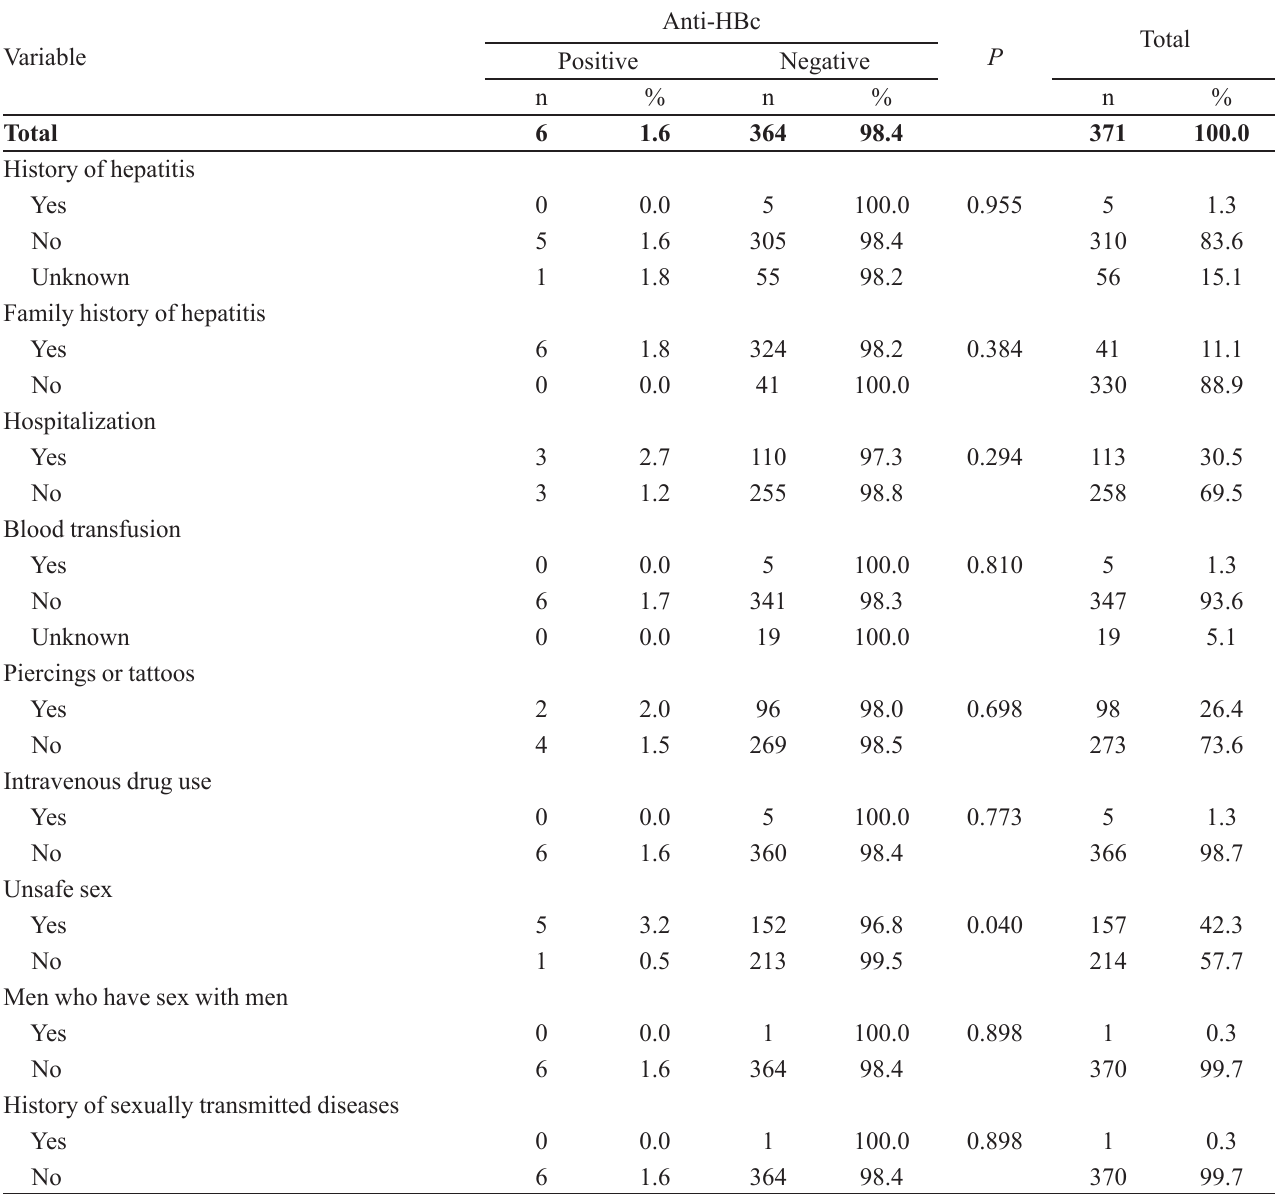
TABLE II - Possible risk factors related to HBV infection in young adults in South Brazil by anti-HBc status